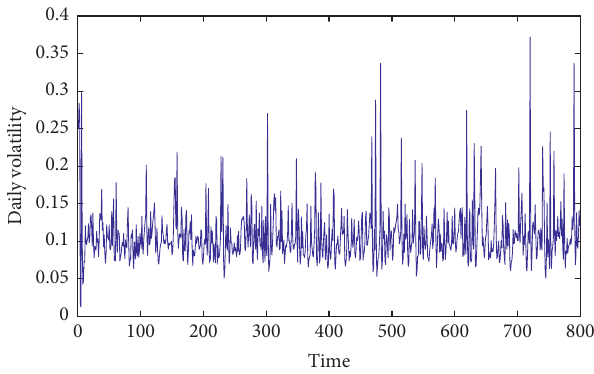
Figure 19: The estimated volatility for T � 800.